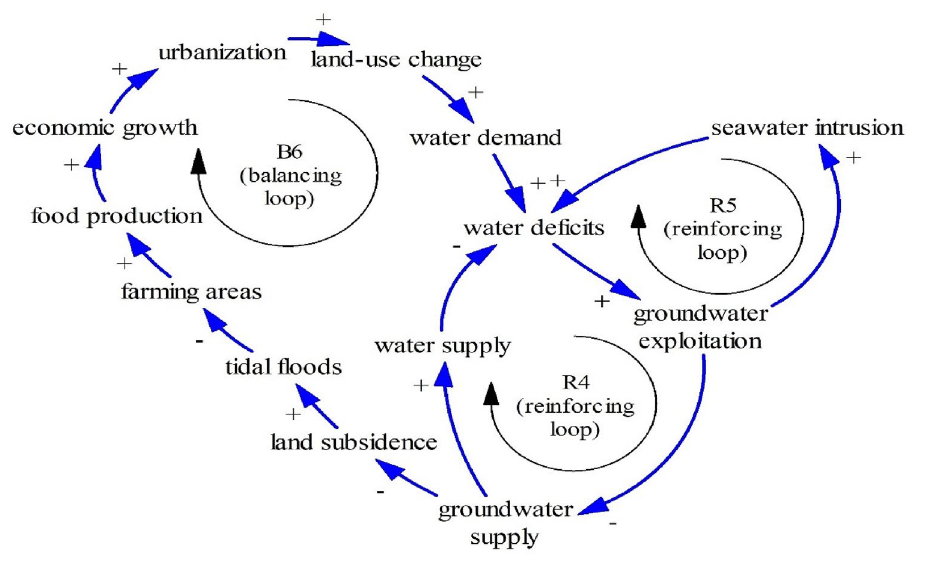
Figure 14. The Limits to Growth